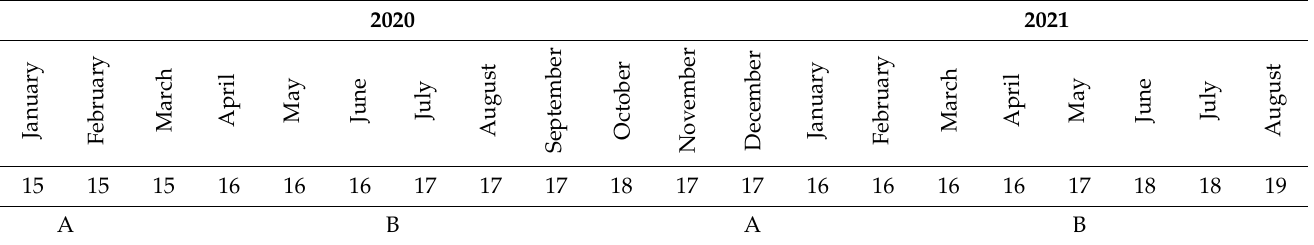
Table 2. Results of locomotion and social adaptability testing using the FIM test in a patient diagnosed with developmental dyspraxia; A—period of monthly testing with no intervention, B—period of intervention and monthly